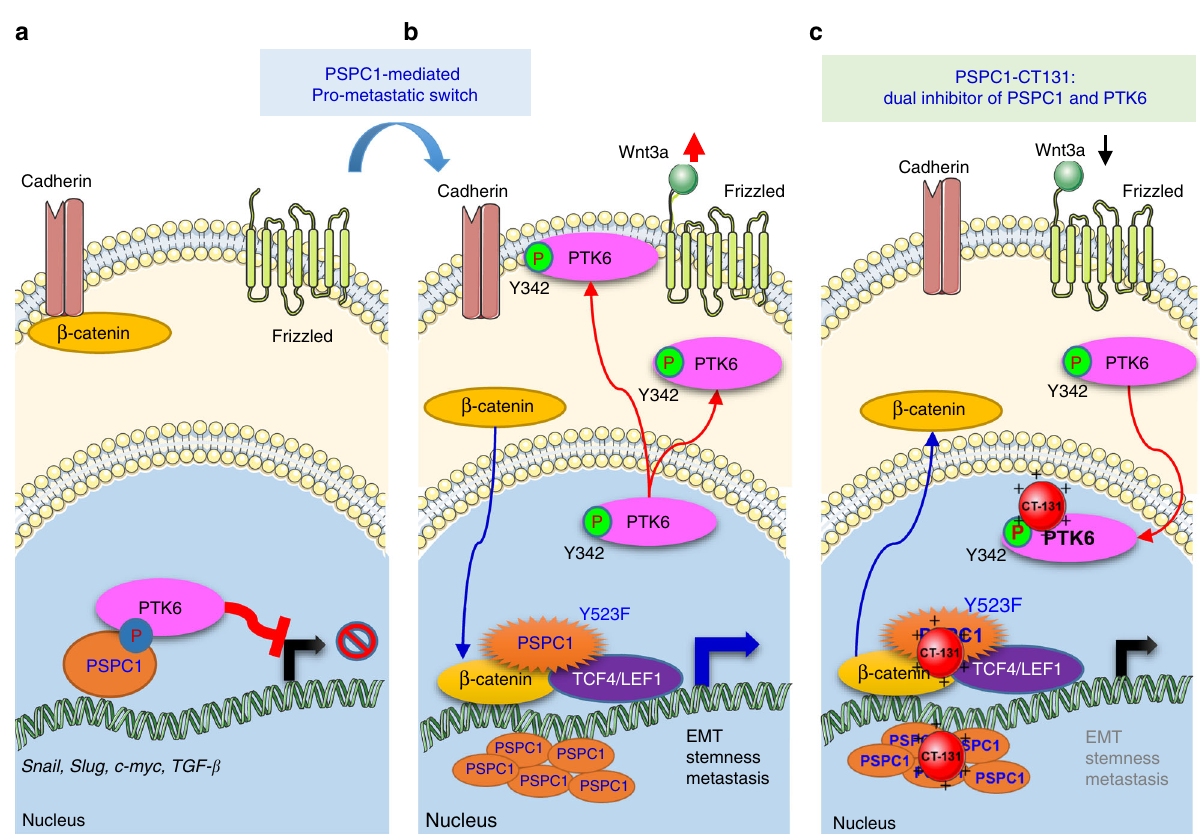
Fig. 8 Hypothetical models of the PSPC1/PTK6 interaction modulating Wnt/ β -catenin autocrine signaling and PSPC1-CT131 as a dual inhibitor of PSPC1 and PTK6 suppressing downstream oncogenic signaling. a PTK6 suppressed PSPC1 oncogenic features by phosphorylation and interaction on Y523 of PSPC1 and was sequestered in the nucleus as a tumor suppressor. b PSPC1 upregulation or mutation of the PTK6 phosphorylation site PSPC1- Y523F augmented Wnt3a autocrine signaling to facilitate β -catenin nuclear and p-PTK6 cytoplasmic/membrane translocations to synergize the oncogenic signaling of both PSPC1 and PTK6, which facilitated EMT, stemness and metastasis. c Treatment of PSPC1-CT131 as a dual inhibitor of PSPC1 and PTK6 reduced the expression of both oncogenic PSPC1 and PTK6 to suppress HCC tumor progression. Overall, PSPC1-CT131, a dual inhibitor of PTK6 tyrosine kinase and PSPC1 pro-metastatic master activator, is a potent anticancer agent that prolongs the survival of mice in an HCC mouse